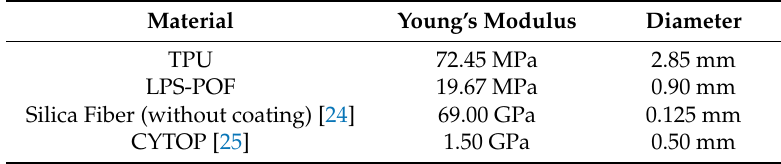
Figure 3. Stress-strain curves. ( a ) Thermoplastic polyurethane (TPU) and ( b ) light spinning polymerization process (LPS-POF). Table 1. Young’s modulus and diameter of the materials used.